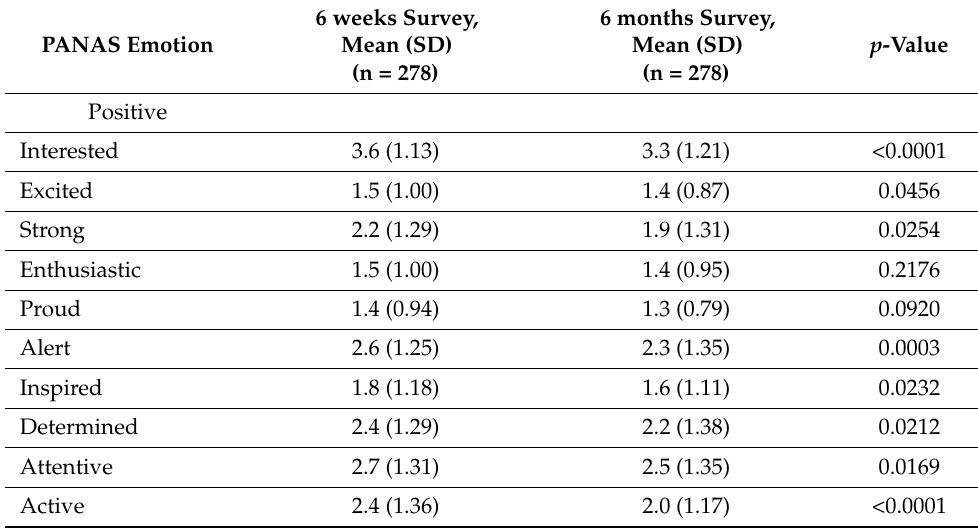
Table 5. Discrete PANAS Emotions and Change Over Time.